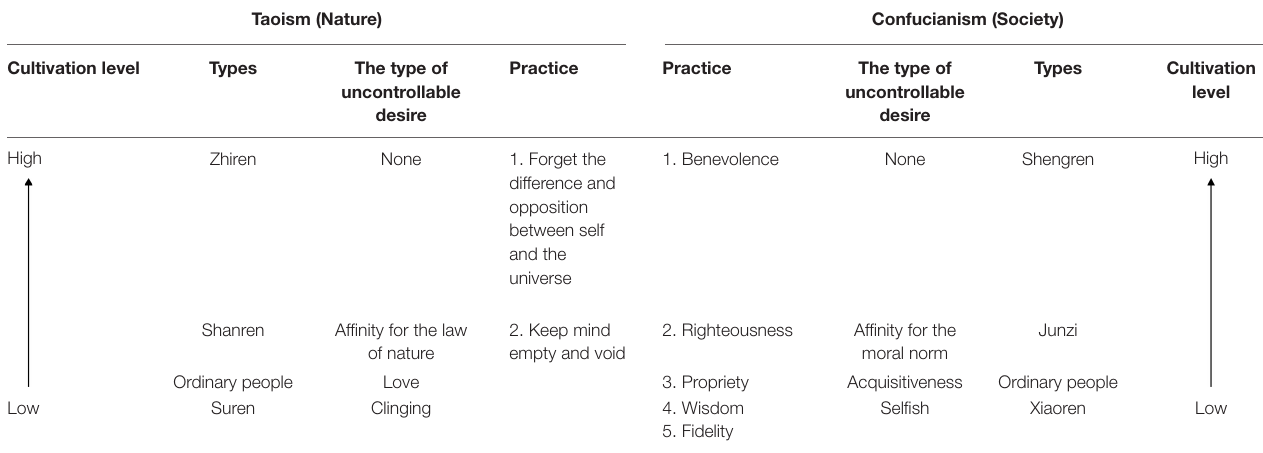
FIGURE 6 | The changes in mental states of Confucianism and Taoism. TABLE 1 | Confucian and Taoist approaches to mental